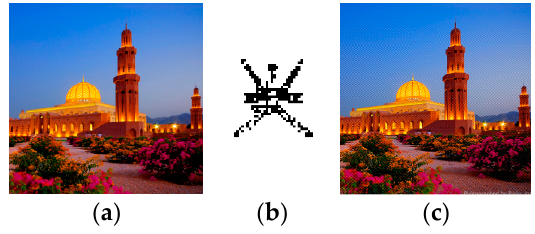
Figure 3. ( a ) Cover Image ( b ) Watermark ( c ) Decoder output.